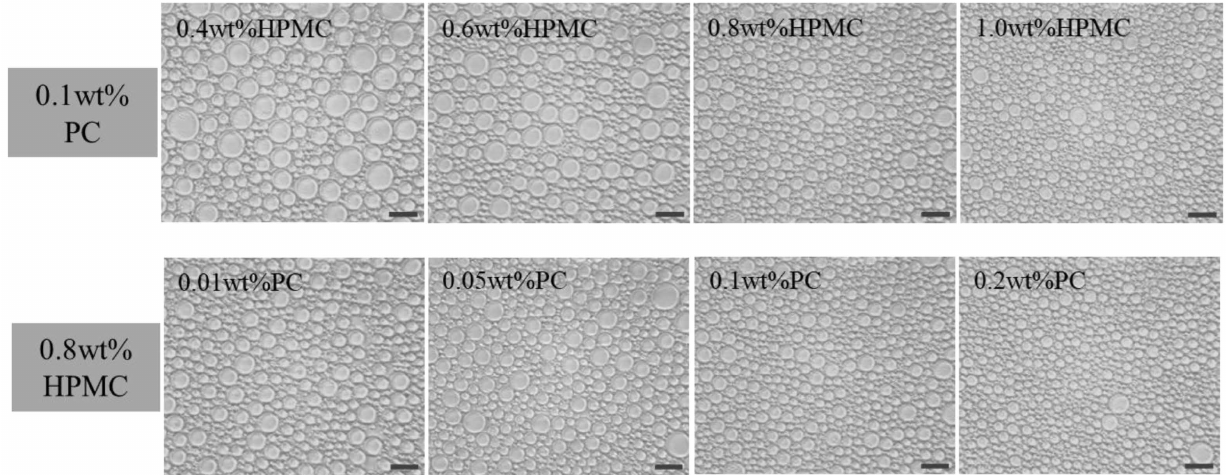
Figure 1. The microstructures of emulsions prepared by different HPMC and PC concentrations. For emulsions where the concentration of HPMC was varied, the concentration of PC was kept constant at 0.1 wt%. For emulsions where the concentration of PC was varied, the concentration of HPMC was kept constant at 0.8 wt%. The ruler is 20 µ m. (HPMC–Hydroxypropyl methylcellulose,